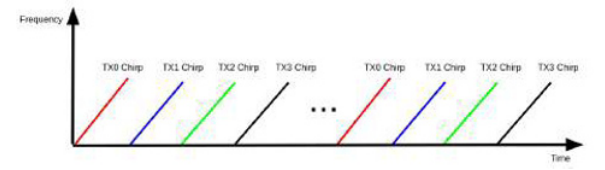
Figure 5. FMCW Signal using TDM, the TX indicates which TR module is transmitting